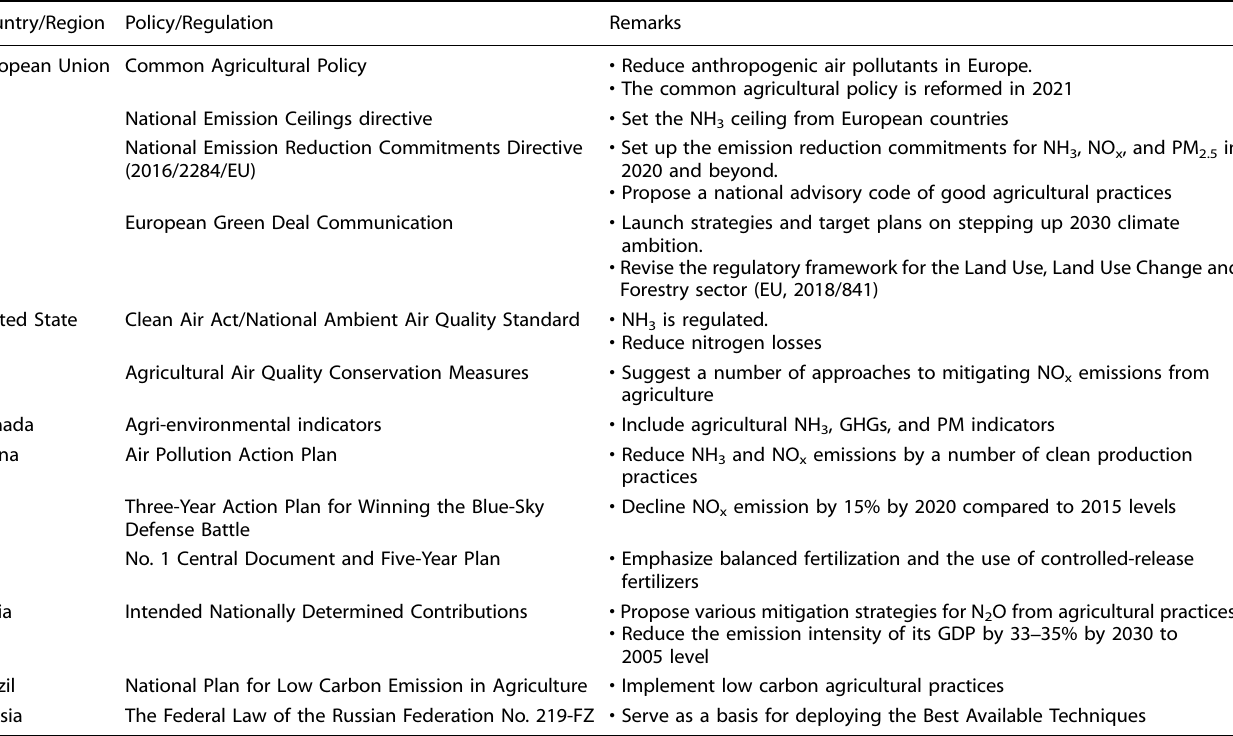
Table 1. Facts and movements on reactive nitrogen emission reduction from agriculture in representative region or country. Country/Region